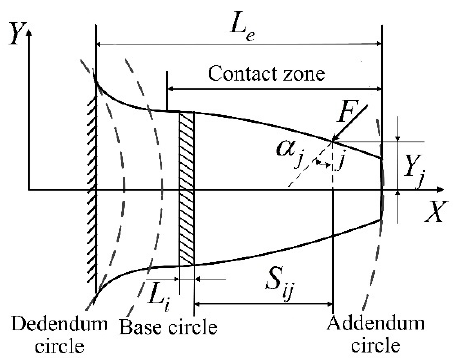
Figure 2. Schematic diagram of a gear tooth cantilever beam.